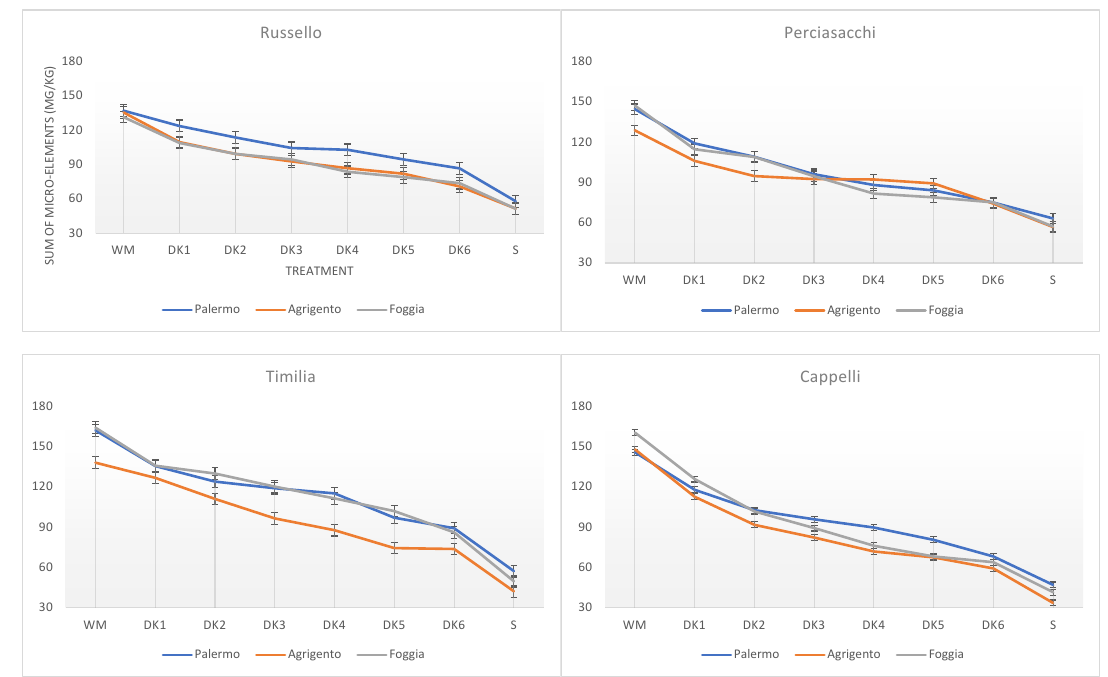
Figure 1. E ff ect of processing (debranning and milling) for four old durum wheat genotypes over three environments: ( a ) ash, ( b ) sum of macro- and ( c ) sum of micro-elements. WM, wholemeal; S, semolina; DK-1 to DK-6, debranned kernels. The bars represent the standard error of the E × T. The red dashed line represents the maximum level of ash equal to 0.9% required by Italian law (DPR 187 / 2001). (For interpretation of the references to color in this figure legend, the reader is referred to the web version of this article).